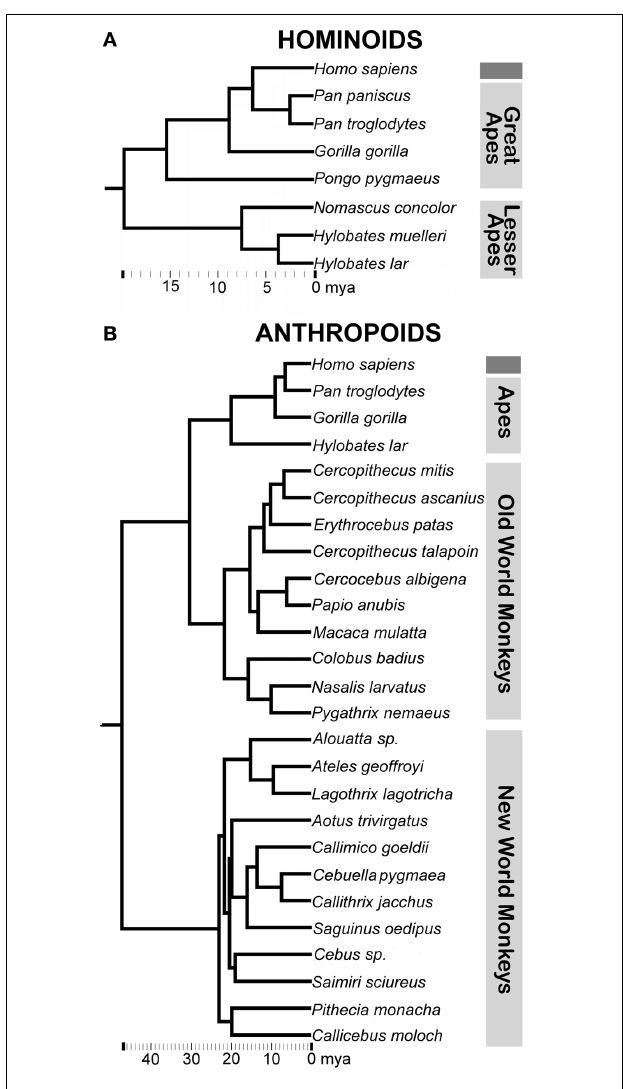
FIGURE 2 | Consensus phylogeny for (A) hominoids and (B) anthropoids in the analysis with common classifications of major non-human primate clades indicated. Branch lengths represent evolutionary distance on the scale of millions of years (mya). Consensus phylogenies drawn from the 10 kTrees